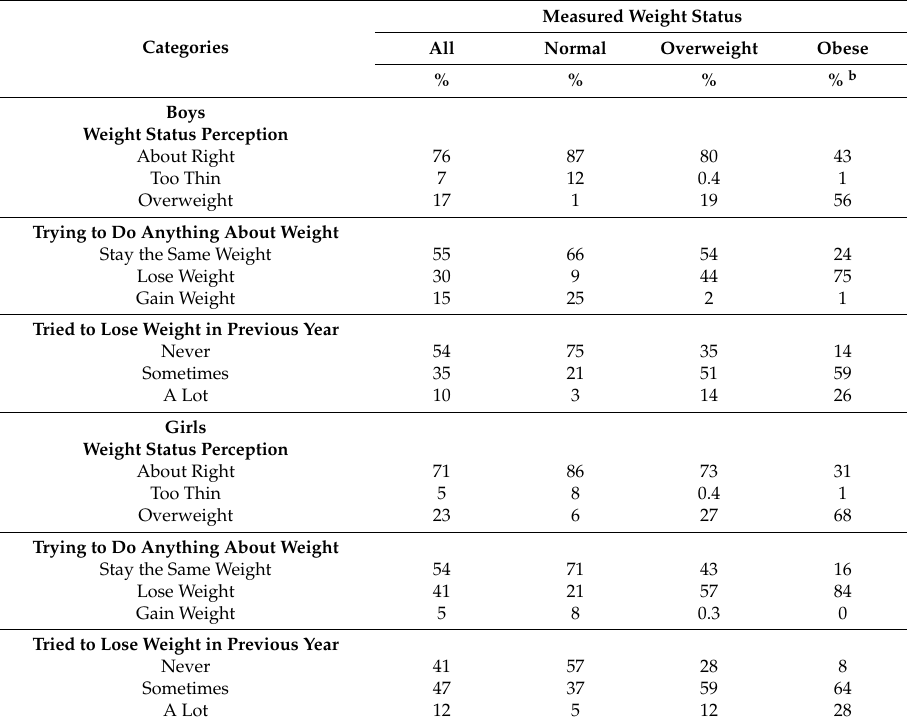
Table 2. Distributions of weight status perception and weight control intentions, stratified by measured weight status (normal, overweight, or obese) and gender, among adolescents participating in the National Health and Nutrition Examination Survey 2005–2014 ( n = 4940) a